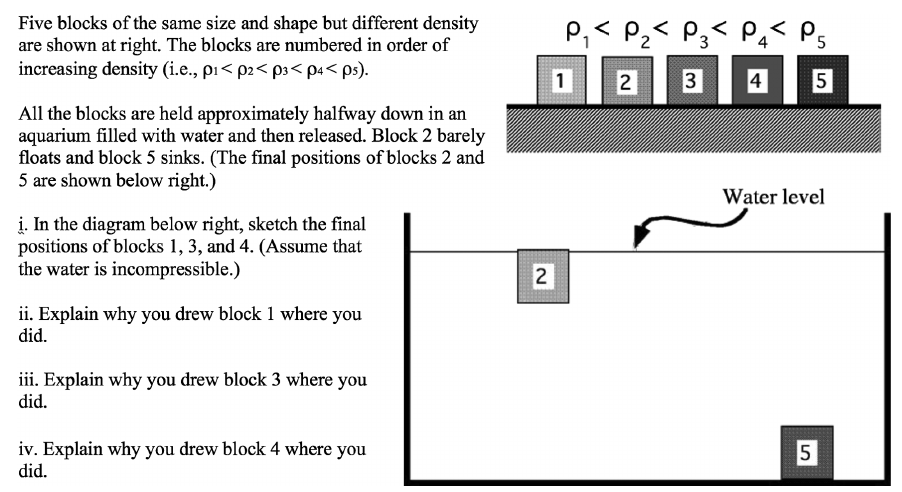
FIG. 6. The modified version of the 5-block problem in experiment 2.2: Ranking of the mass is replaced by ranking of